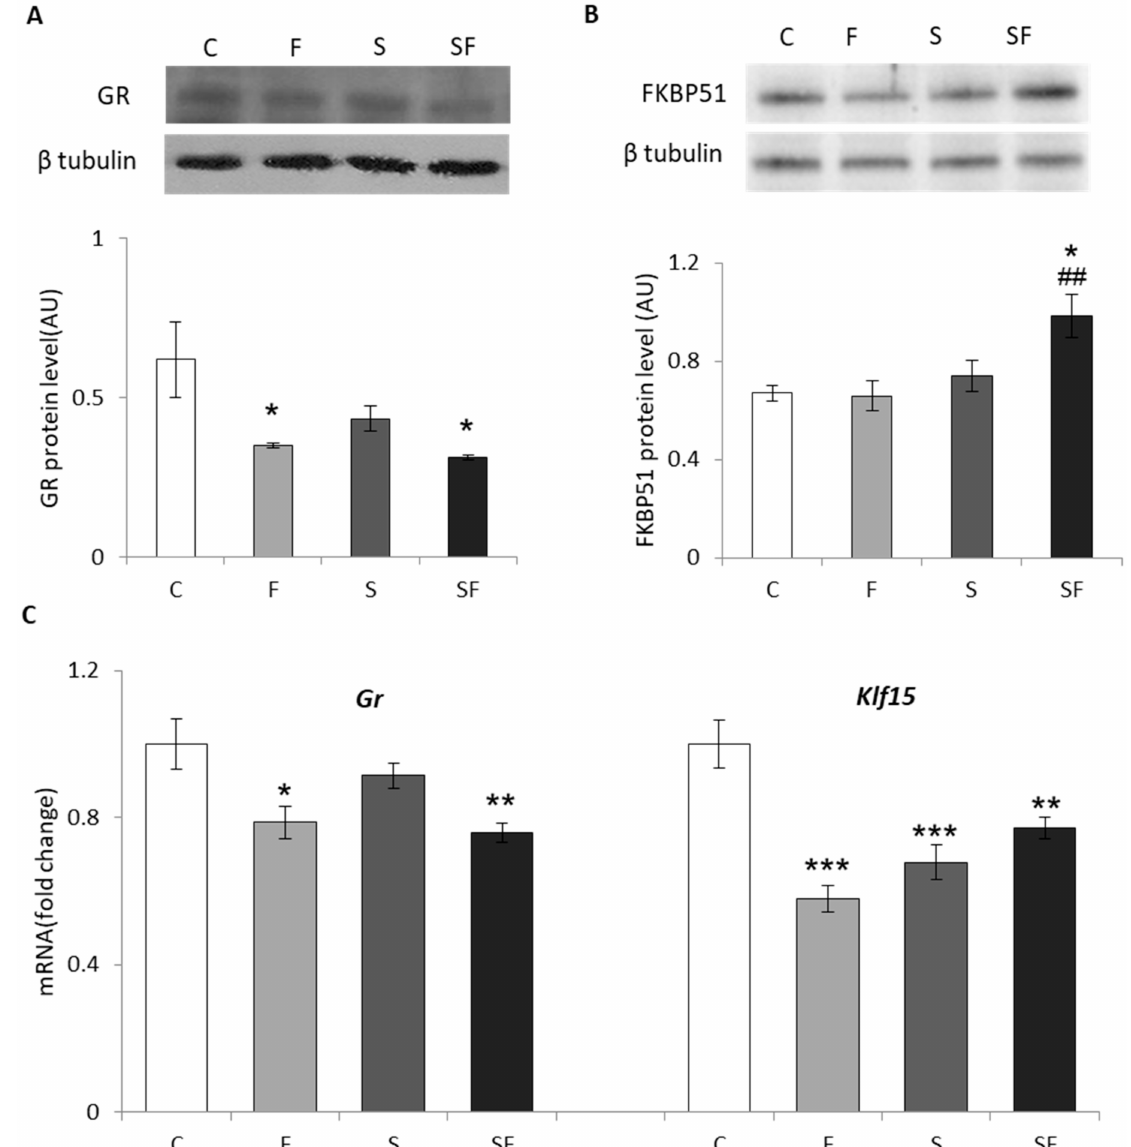
Figure 5. Glucocorticoid receptor signaling pathway in skeletal muscle of control (C), fructose (F), stress (S), and stress + fructose (SF). Protein levels of GR ( A ) and FKBP51 ( B ) were measured by Western blot in the muscle tissue extracts. The values represent the mean ± SEM for each protein normalized to β tubulin expressed in arbitrary units (AU). GR and KLF15 mRNA levels ( C ) compared to HPRT mRNA were determined by TaqMan real-time PCR in the skeletal muscle. The values represent the mean ± SEM (n=8-9 animals per group). All measurements were done in triplicate. Significant between-group differences from post hoc Tukey test are given as follows: * p < 0.05, ** p < 0.01, *** p < 0.001, treated groups vs. C; ## p < 0.01, SF vs. F. GR—glucocorticoid receptor; FKBP51—FK506-binding protein 51; KLF15—Kruppel Like Factor 15; HPRT—hypoxanthine